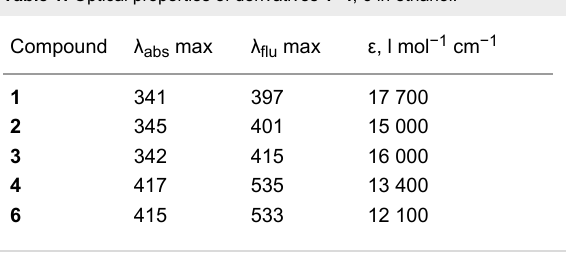
Table 1: Optical properties of derivatives 1 – 4 , 6 in ethanol.